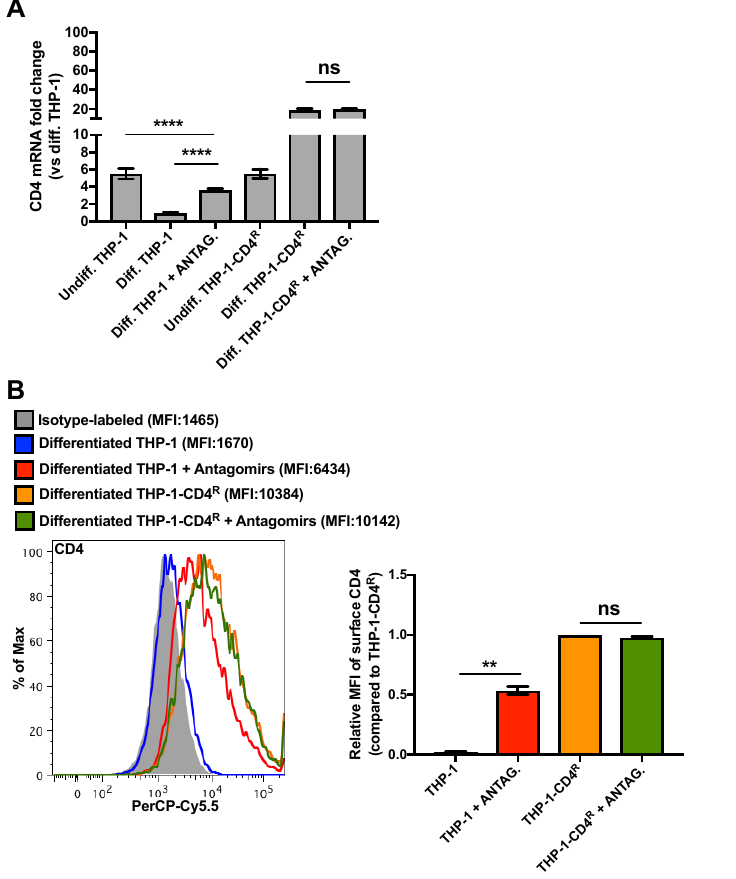
Figure 5. MiR-221/miR-222 antagomirs restore CD4 expression in differentiated THP-1 cells to that of levels in undifferentiated THP-1 cells. ** p < 0.01 and **** p < 0.0001. ( A ) Control THP-1 or THP-1-CD4 R cells were PMA-differentiated and transfected with a mix of miR-221/miR-222 antagomirs. CD4 mRNA levels were then measured by qRT-PCR ( n = 6; means ± SD are shown and compared using Student’s t test). ( B ) The levels of surface CD4 of the previously described cells were assessed by cytofluorometry; a graph of a representative experiment is shown (left panel; geometric MFIs are shown in parentheses) and a bar graph of the relative geometric MFIs ( n = 2; means ± SD are shown and compared using Student’s t test) is provided in the right